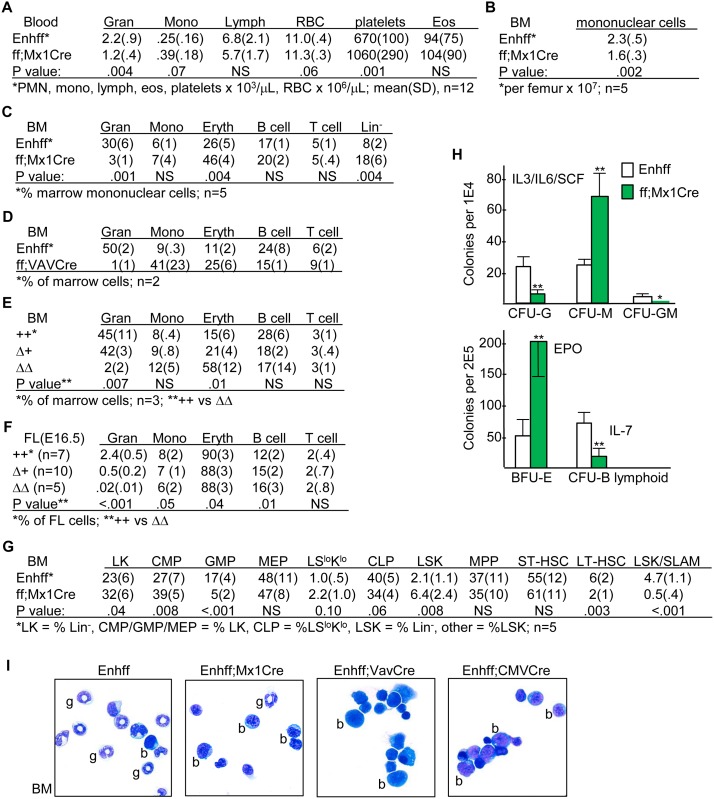
Effect of in vivo Enhancer Deletion on Hematopoiesis.A) Peripheral blood counts from 14–16 wk old Enh(f/f) and Enh(f/f);Mx1-Cre mice obtained 4 wks after completion of pIpC injections. B) Total marrow cellularity from Enh(f/f) versus Enh(f/f);Mx1-Cre mice exposed 4 wks earlier to pIpC. C) Marrow CD11b+Gr-1+ granulocytes, CD11b+Gr-1- monocytes, Ter119+ erythroid cells, B220+ B cells, CD3+ T cells, or Lin- cells lacking these markers from these same mice. D) Marrow granulocytes, monocytes, erythroid, B and T cells from 4 wk old Enh(f/f) and littermate Enh(f/f);Vav-Cre mice. E) Marrow granulocytes, monocytes, erythroid, B and T cells from 5 wk old Enh(f/f) (++), Enh(f/+);CMV-Cre (Δ+), and Enh(f/f);CMV-Cre (ΔΔ) mice. F) E16.5 FL cells obtained from embryos of indicated genotypes derived from Enh(f/+);CMV-Cre (Δ+) parents were subjected to FACS analysis for these same hematopoietic subsets. G) Marrow stem/progenitor subsets, as determined by FACS analysis, from the same mice evaluated in B and C. H) Myeloid, BFU-E, and B lymphoid CFUs were in enumerated after culture at 1E4 cells/mL in methylcellulose in the presence of IL-3/IL-6/SCF or at 2E5 cells/mL in EPO or IL-7, respectively (mean and SD from three determinations). I) Morphology of marrow obtained from Enh(f/f) or Enh(f/f);Mx1-Cre mice 4 wks after pIpC injections and from Enh(f/f);Vav-Cre or Enh(f/f);CMV-Cre mice.